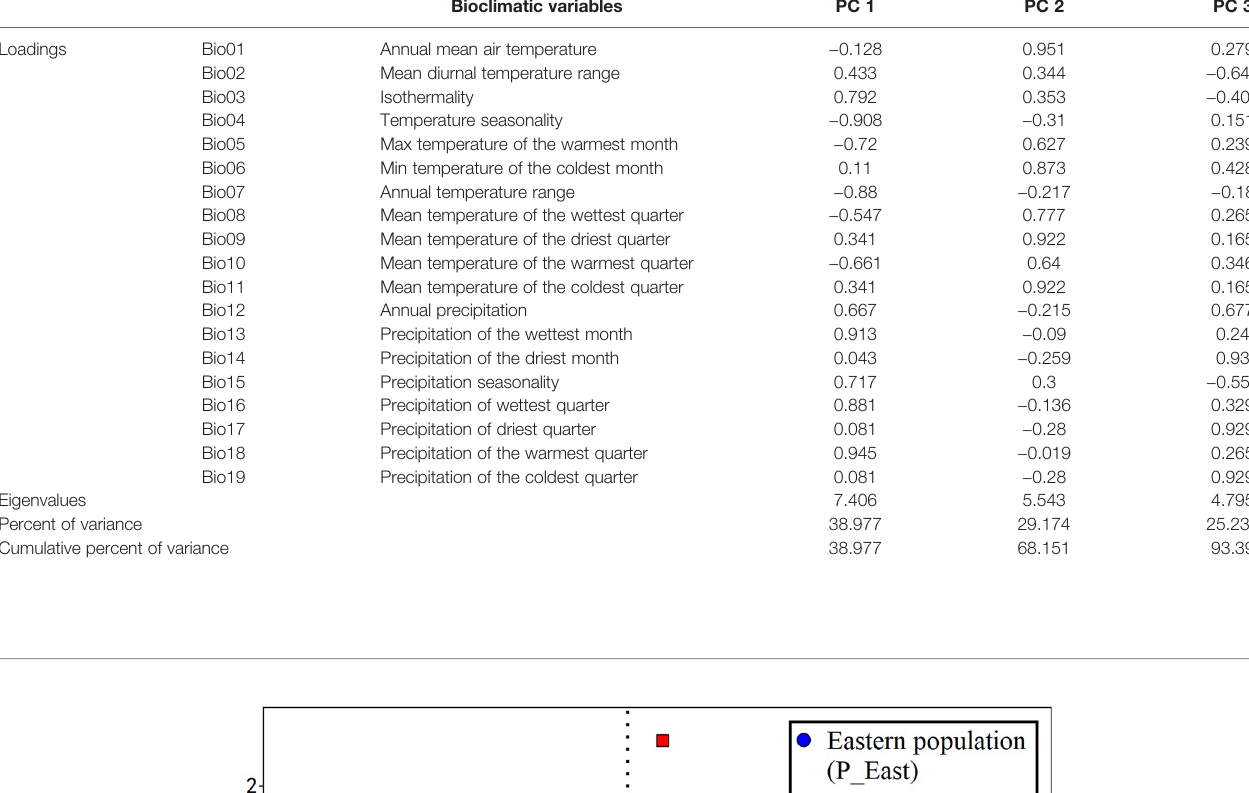
TABLE 1 | Correlation between components and variables and variance explained.